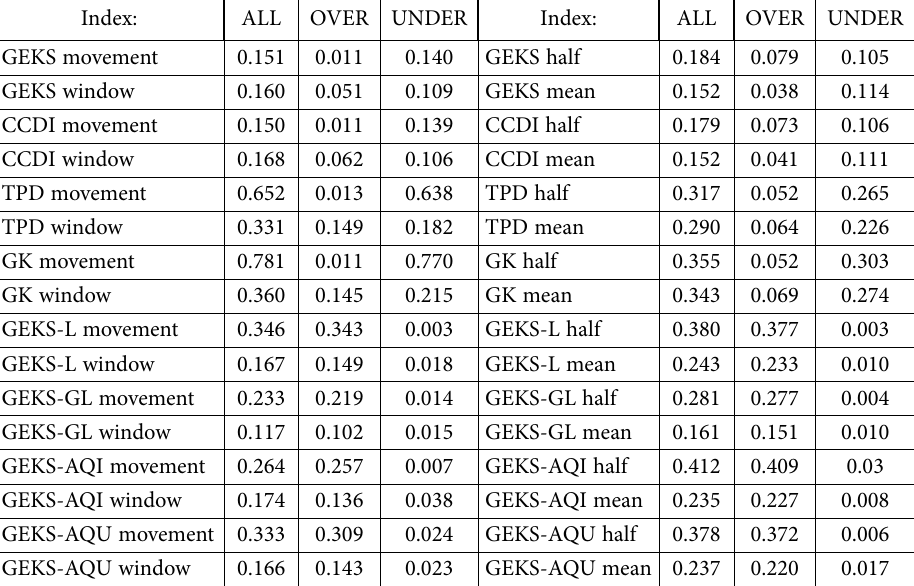
Table 5. Mean absolute distances between considered splice indices and the corresponding target full- window index for sugar products